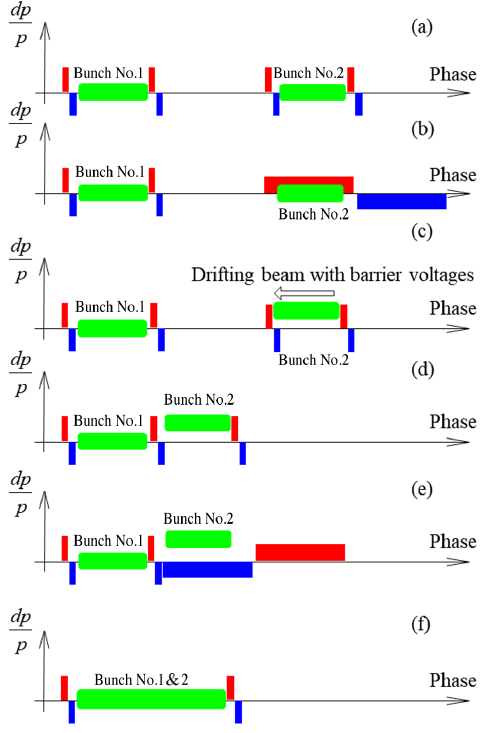
FIG. 2. Beam manipulation in the offDBB. Positive and negative voltages are in red and blue, respectively. (a) Bucket voltages confine bunches No. 1 and No. 2. (b) Bunch No. 2 is accelerated by a long positive voltage pulse. (c) Bucket voltages confine bunches No. 1 and No. 2, and the right bucket moves towards the left. (d) Bunch No. 2 is adjacent to bunch No. 1. (e) Bunch No. 2 is decelerated by a long negative voltage pulse and becomes on-momentum. (f) Bunches No. 1 and No. 2 are combined after the intermediate voltages are turned off, and the new long bunch is confinable with the new barrier